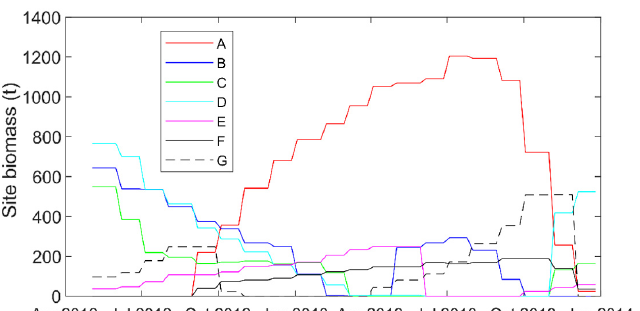
Fig. 2. Lepeophtheirus salmonis site counts. Fish farm site sea lice counts (sum of all attached stages), normalised by maximum total lice count for any farm over the study period, and aggregated by alphabetical farm grouping identified in Fig. 1. Each site count is the average number of lice on 25 randomly selected fish